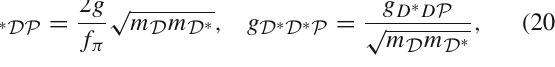
Fig. 2 (Color online). a The α -dependence of the branching ratios of h c → γη ( solid line ) and γη (cid:3) ( dashed line ), respectively. The η – η (cid:3) mixing angle θ P = − 19 . 3 ◦ is from Ref. [59]. b The α -dependence of